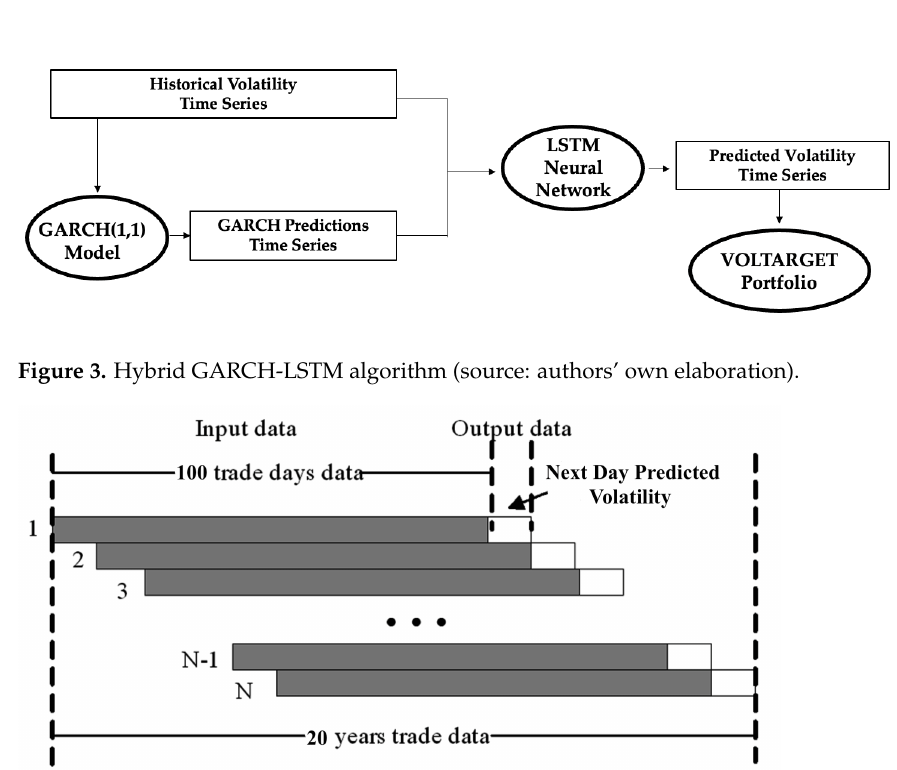
Figure 4. The input data have a length of 100 days, producing an output for 1 day. The original figure from Guo et al. (2015) was adjusted by the